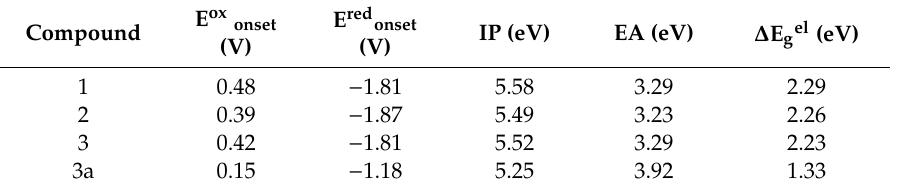
Table 1. Redox properties of monomers. IP—ionization potential, estimated from equation